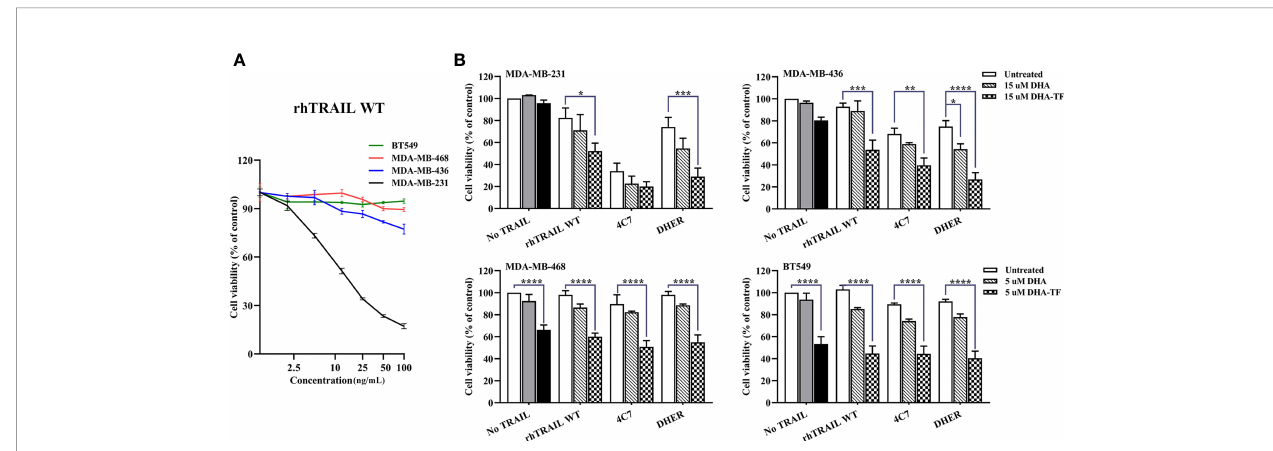
FIGURE 5 | DHA-TF adducts enhance TRAIL ef fi cacy in TRAIL-sensitive TNBC cell lines. (A) The sensitivity of TNBC cell lines to TRAIL-induced apoptosis. All cell lines were treated with different concentration of rhTRAIL WT for 24 h. (B) All cell lines were pre-treated with DHA or DHA-TF for 30 min, followed